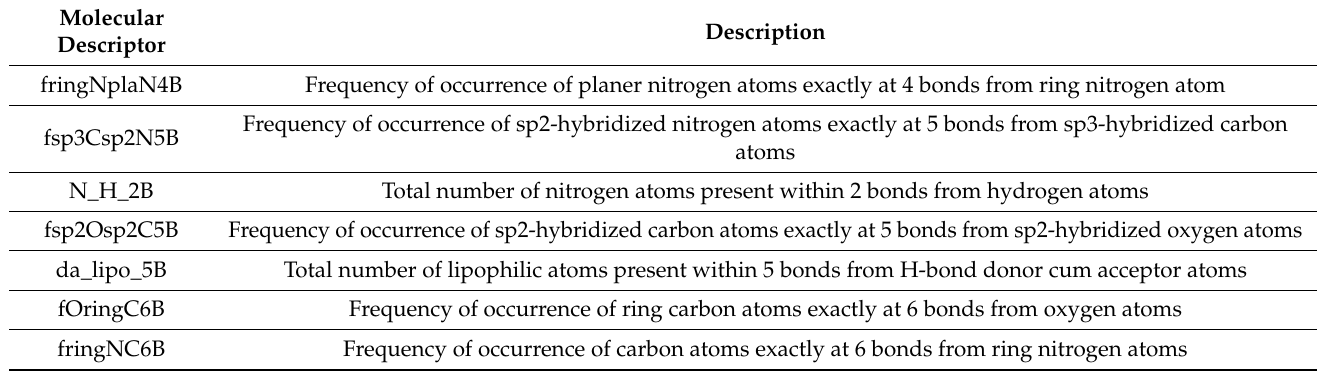
Table 1. Different molecular descriptors present in model A and their